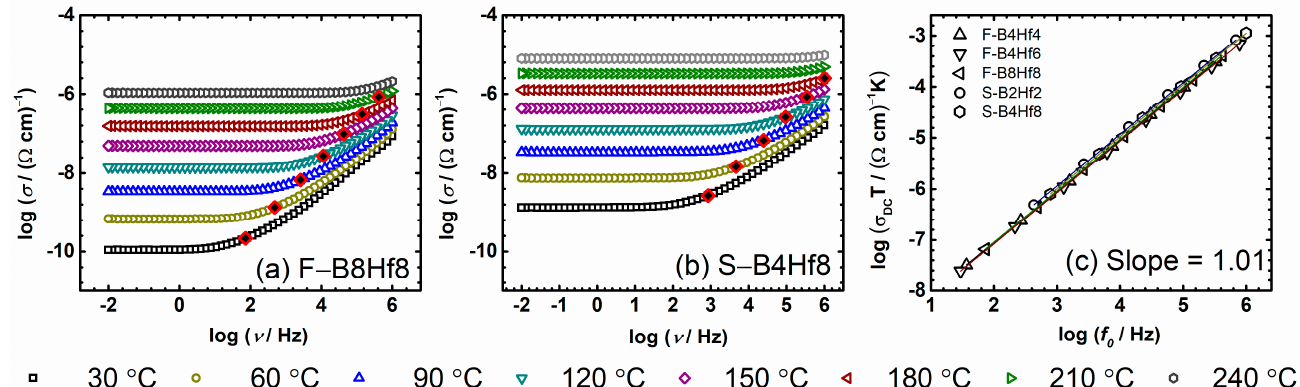
Figure 4. Conductivity spectra for samples ( a ) F–B8Hf8 and ( b ) S–B4Hf4 from series F and S, respectively. Filled squares denote the frequencies of the onset of conductivity dispersion defined at f 0 = 2 σ DC . ( c ) Log-log plot of the two scaling parameters σ DC T and f 0 for several compositions from both series. The straight lines are obtained by least-squares linear fits to experimental data and have a slope of 1.01 ± 0.01 for all studied samples.